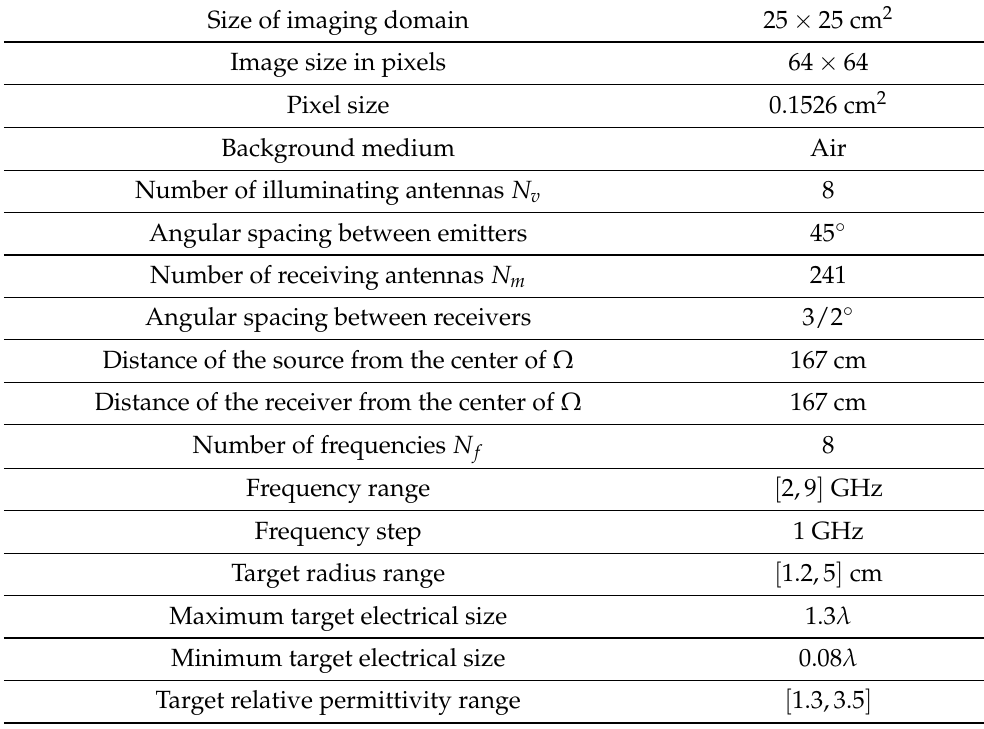
Table 1. Simulations for training data generation.